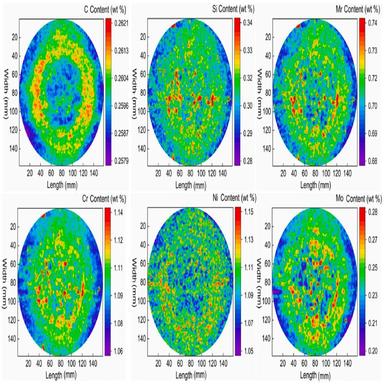
Corrected 2-D content distribution of C, Si, Mn, Cr, Ni, Mo of row mapping: in-row corrected by linear and inter-row corrected by total average.